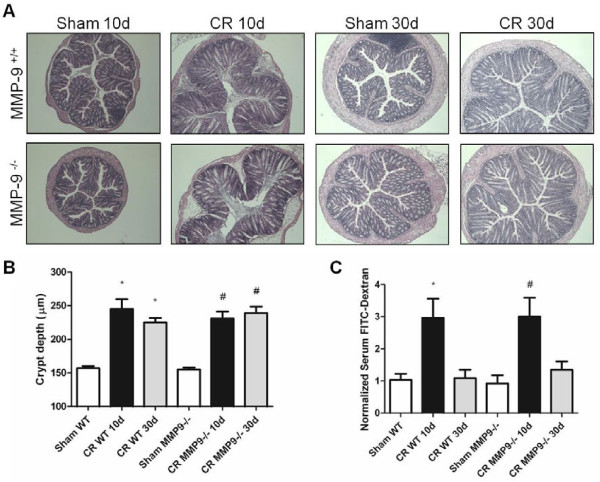
MMP-9−/−and WT mice infected
withC. rodentiumhave similar histopathology
and mucosal barrier dysfunction. (A) Representative H
& E stained images of colonic tissues demonstrating C.
rodentium-induced inflammation in MMP-9+/+ and
MMP-9−/− mice. Scale bar, 100 μm.
(B) Quantitative analysis shows significant increases in
colonic crypt height in MMP-9+/+ and
MMP-9−/− mice at 10d and 30d PI,
compared to sham-infected mice. N = 12-18. (C)
Fluorometric analysis of a 4 kDa FITC-dextran probe in serum
samples obtained from WT and MMP-9−/− mice in the
presence or absence of C. rodentium infection (10d and 30d PI).
*P<0.05 compared to Sham WT;
#P<0.05 compared to Sham
MMP-9−/−. N = 7-17.